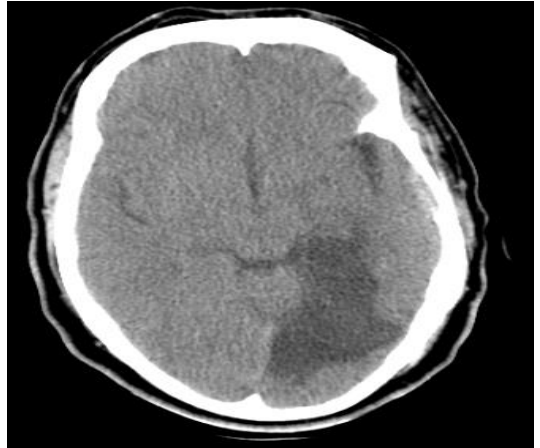
Figure 2. Computed tomography scan showing left temporal and occipital lobes ischemia